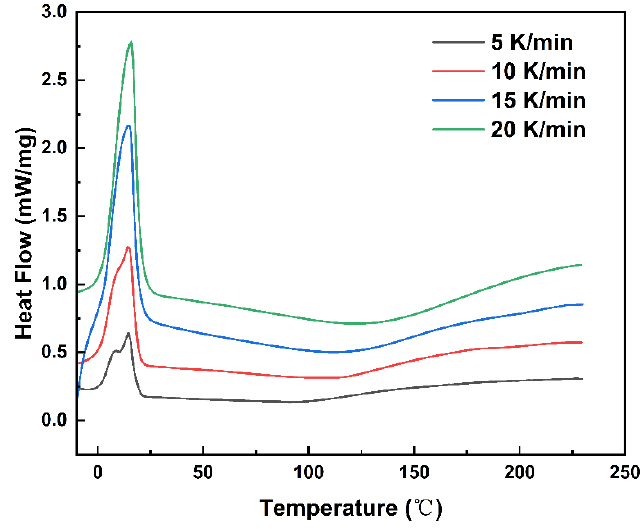
Figure 1. DSC results of the MDI-based polyurethane at different heating rates. Table 1. Characteristic temperatures and exothermic enthalpy of the MDI-based polyurethane at different heating rates.